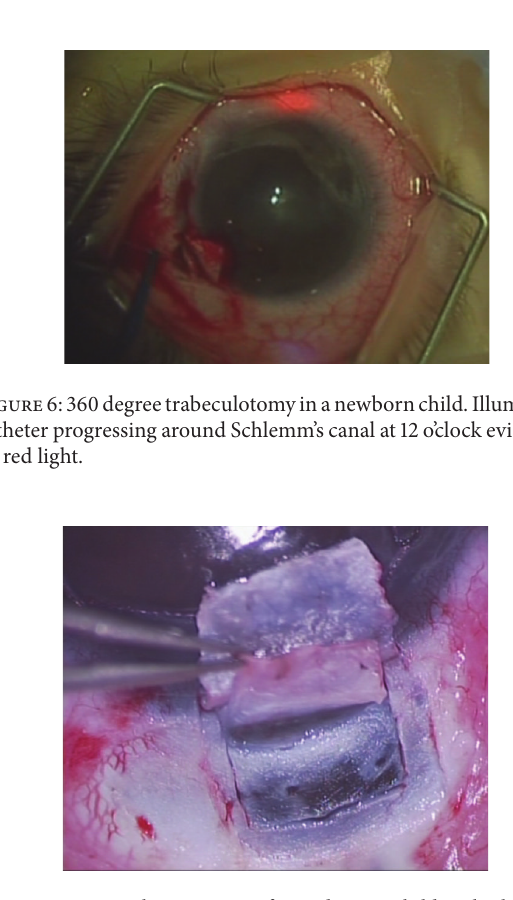
Figure 7: Deep sclerectomy performed in a a child with glaucoma secondary to Sturge-Weber